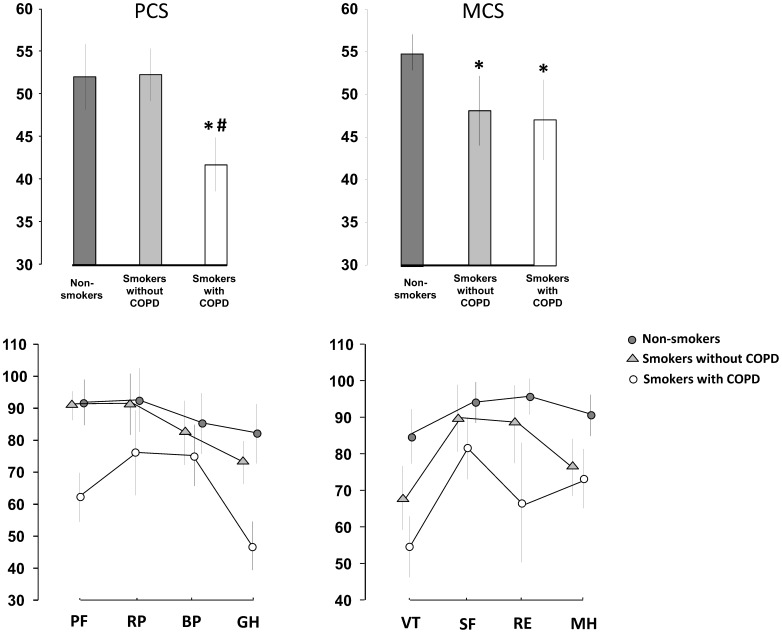
Quality of life assessed by the general quality of life instrument SF-36 in 28 smokers with COPD, 29 smokers with no airflow limitation and 23 healthy non-smokers.PCS: physical component summary, MCS: mental component summary, PF: physical functioning, RP: role-physical, BP: bodily pain, GH: general health, VT: vitality, SF: social functioning, RE: role emotional, MH: mental health. Data are presented as mean values and 95% confidence intervals. *indicates p<0.001 compared with non-smokers. #indicates p<0.001 compared with smokers without COPD.